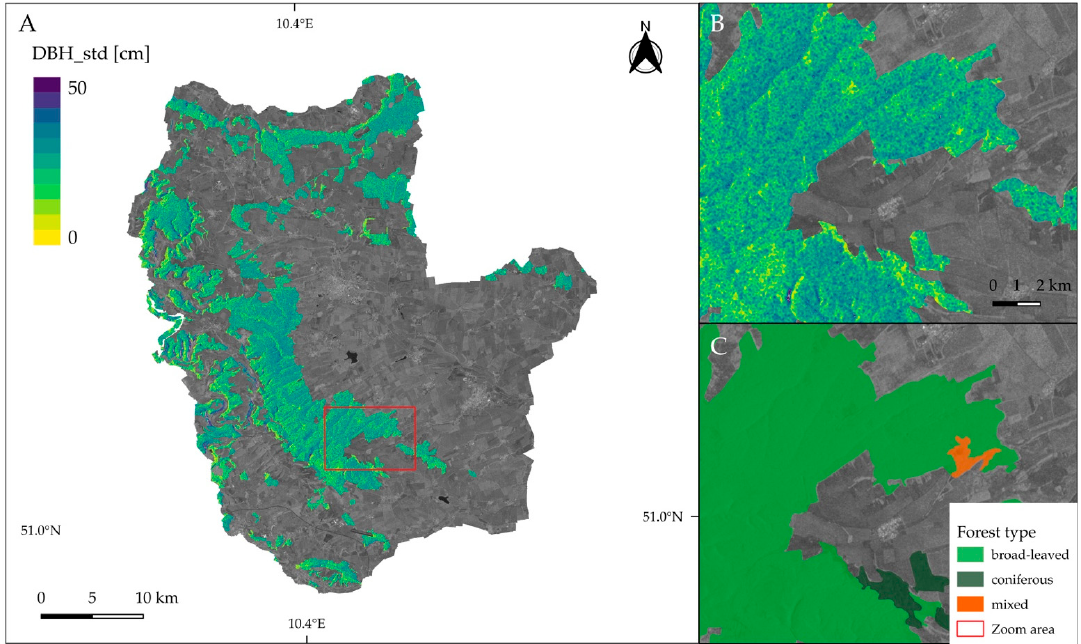
Figure 12. Map of predicted standard deviation of tree diameter (DBH_std) for Hainich-Dün ( A ). A